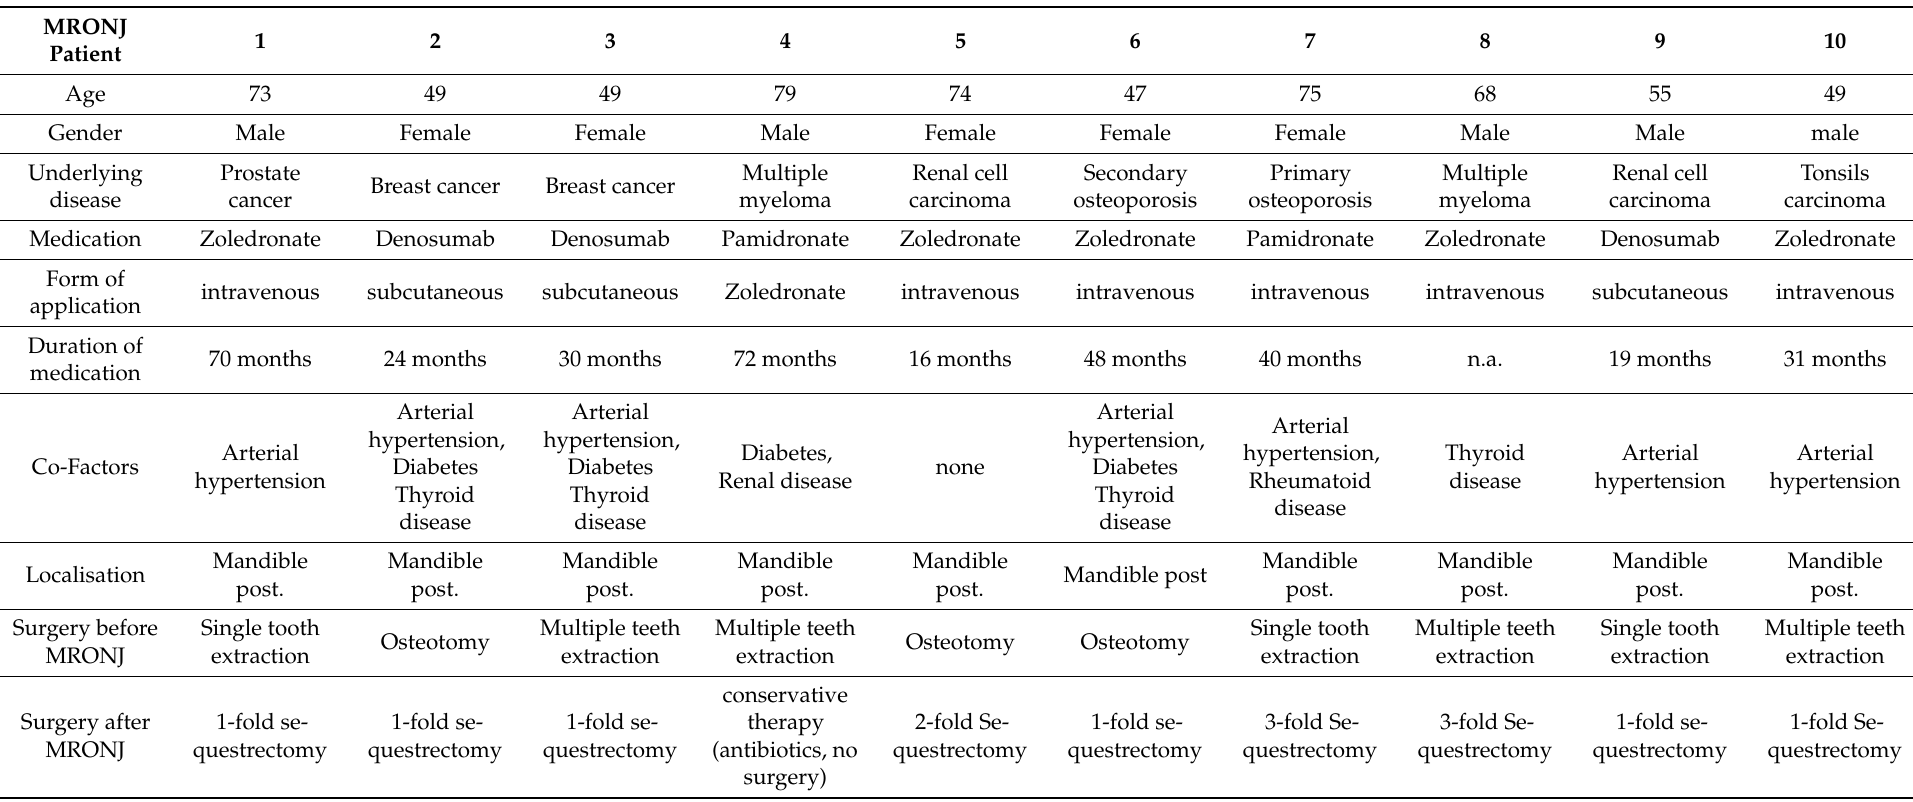
Table 3. Illustration of MRONJ patients n = 10 and details (age, sex, underlying disease, medication, form of application, duration of medication, co-factors, localisation, surgery before MRONJ, surgery after